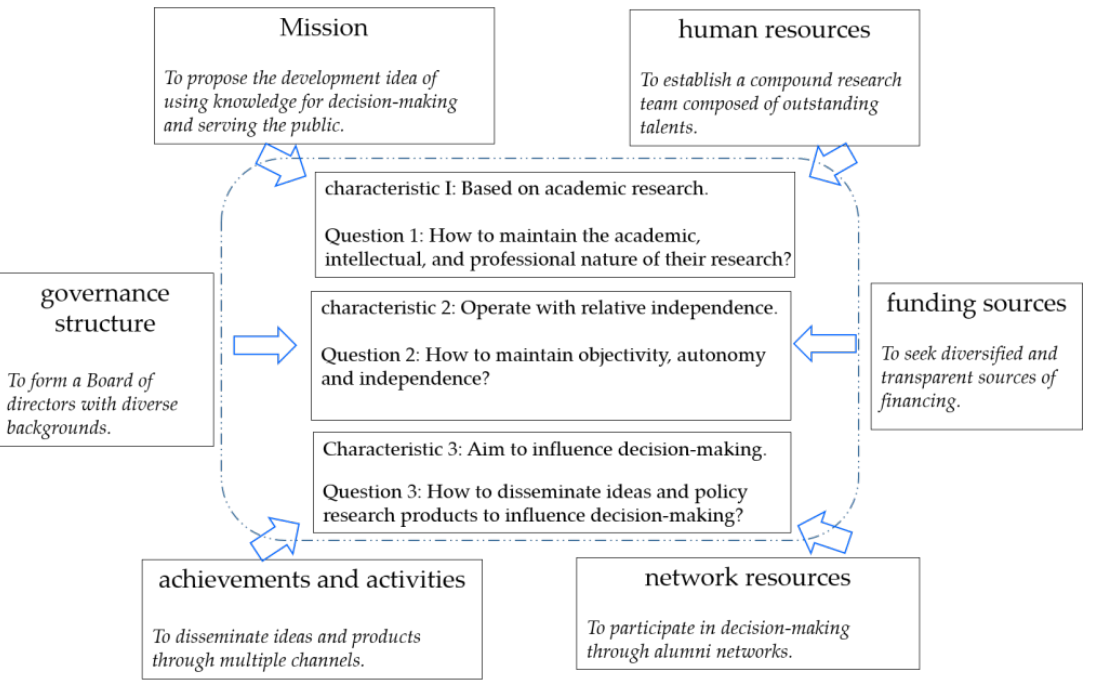
Figure 2. Framework diagram of university think tankgeneration path and formation mode.